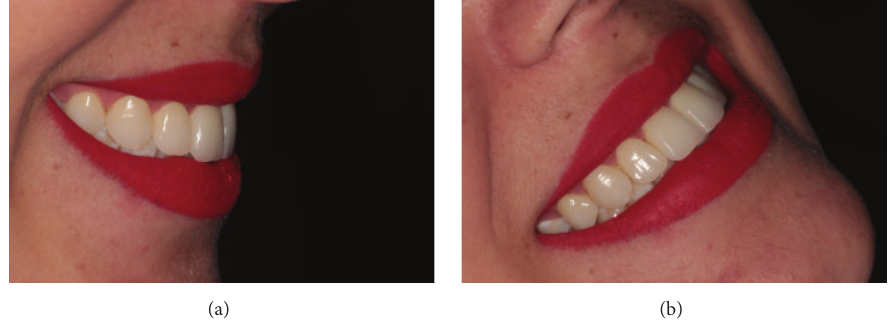
Figure 10: (a)-(b) The final smile achieved for this